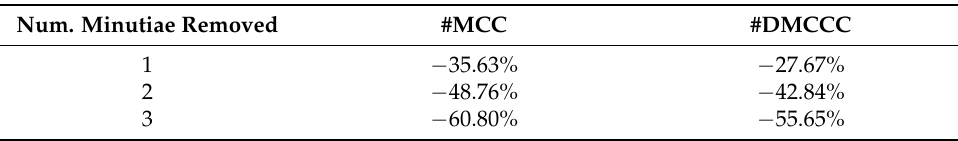
Table 2. Percentages in which there was a rank drop taking into account only those minutiae labeled with the class